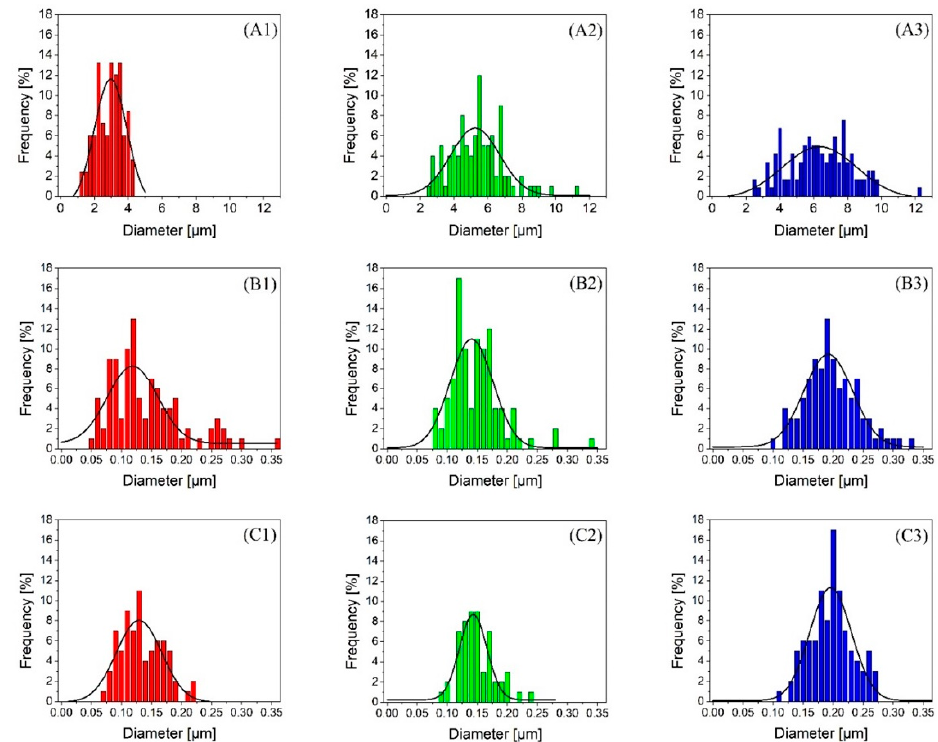
Figure 4. Size distributions of PET spherical and nanofiber diameters. 1, 2, and 3 denote PET concentrations of 3, 7, and 15 wt.%, respectively. ( A – C ) denote prespunbond, postspunbond, and post-MNL processing stages, respectively. Table 2. The average diameter and standard deviation of PET droplets and fibers under di ff erent PET concentrations and processing stages; “sph” denotes spherical PET, “fib1” denotes fibrillar PET in the postspunbond stage, and “fib2” denotes fibrillar PET in the post-MNL stage.